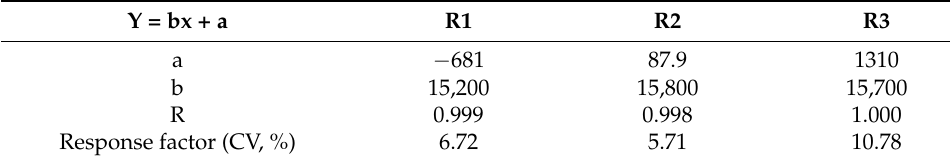
Table 3. Mean parameters of the calibration curves for ceftaroline in